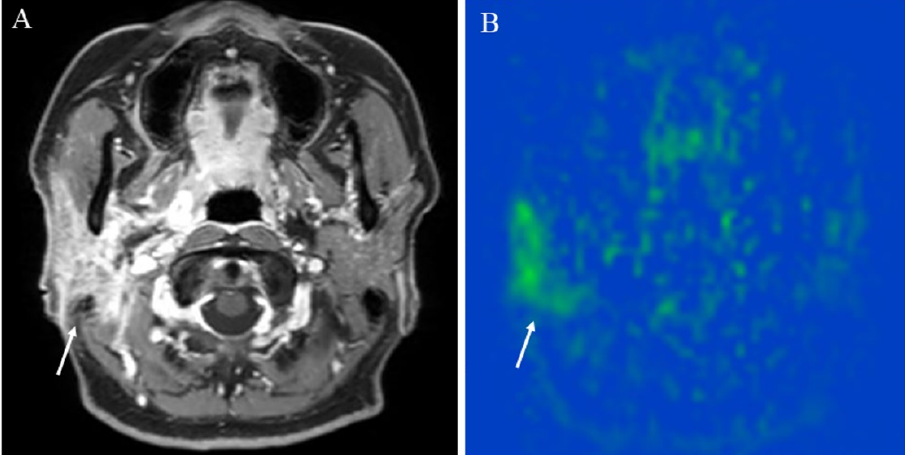
Figure 4. A 48-year-old female with right chronic parotitis: ( A ) Contrast-enhanced T1-weighted image shows intense right parotid gland enhancement (arrow); ( B ) pCASL image shows higher blood flow within the lesion (arrow) (right mean of 81.17 mL/100 g/min) than the opposite parotid gland (left mean of 36.82 mL/100 g/min).